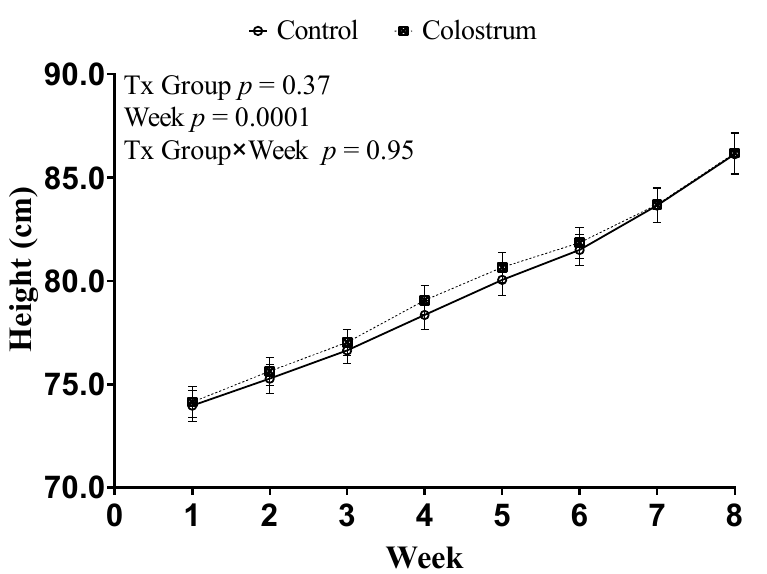
Figure 3. Least squares means of repeated measures ANOVA of withers height (cm) during the pre-weaning period. Treatments: control (CON) received 4 L of colostrum within 2 h of life followed with 3 L of acidified milk within 12–16 h later; Colostrum (COL) received 4 L of colostrum within 2 h of life followed with another 3 L of colostrum 12–16 h later. Error bars represent standard error. Enrollment block was included as a random effect.